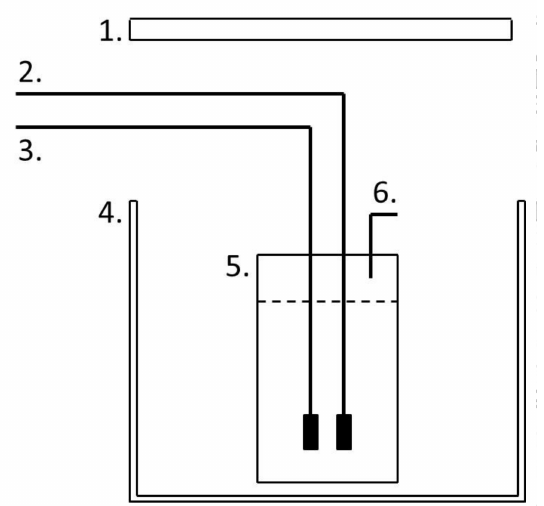
Figure 1. The 1 L Duran bottle reactor. (1) Light source. (2) Mixing airline. (3) Exhaust gas line from compressor. (4) Growth chamber. (5) Culture vessel. (6) Gas and sampling outlet